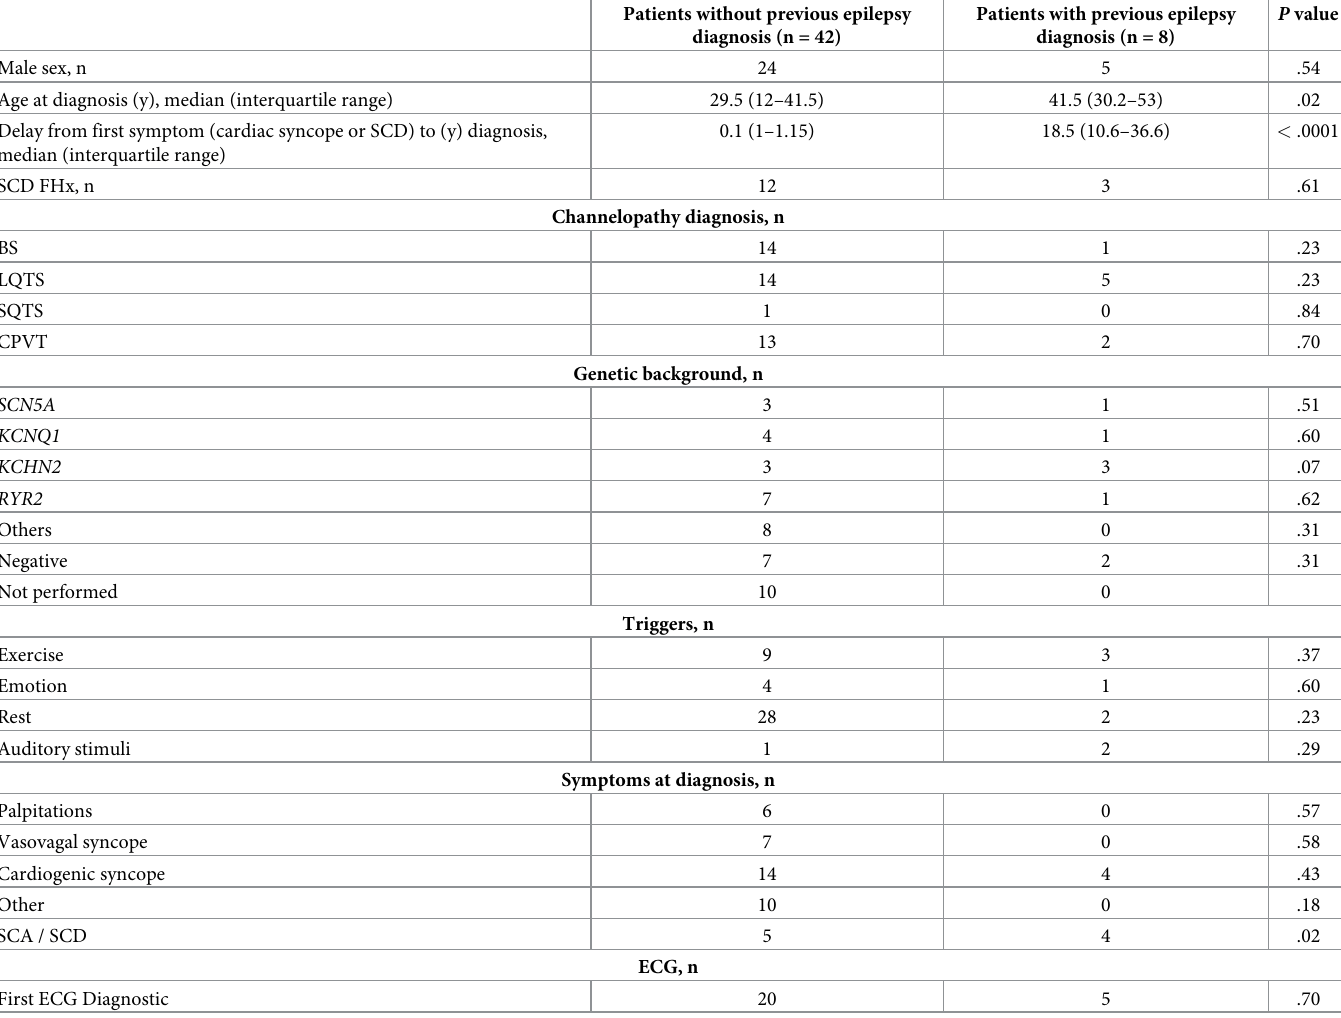
Table 1. Clinical features of probands. BS: Brugada syndrome; CPVT: catecholaminergic polymorphic ventricular tachycardia; ECG: electrocardiogram; FHx: family his- tory; LQTS: long QT syndrome; SCA: sudden cardiac arrest; SCD: sudden cardiac death; SQTS: short QT